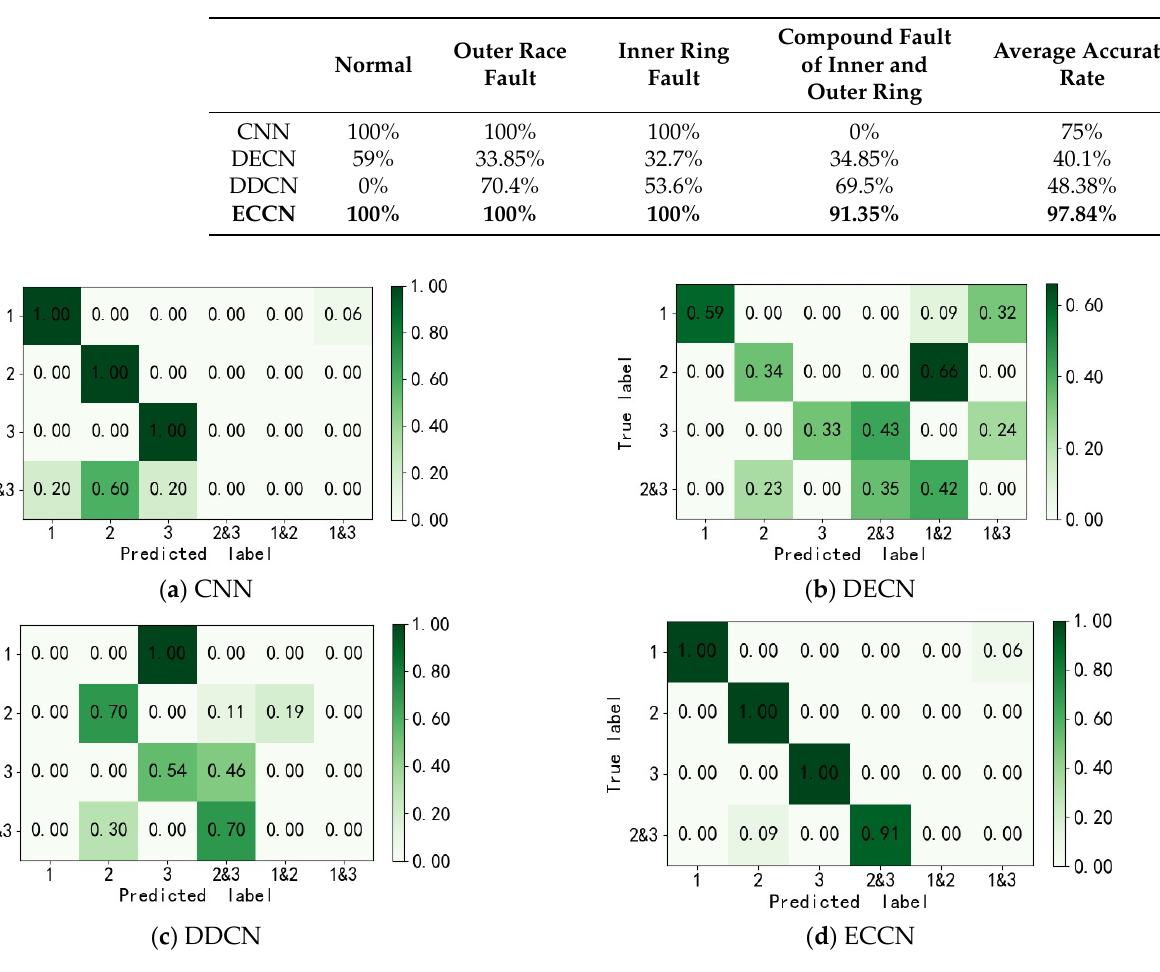
Figure 16. Bearing dataset classification confusion matrix ( a ) CNN; ( b ) ECCN; ( c ) DDCN; ( d ) ECCN.